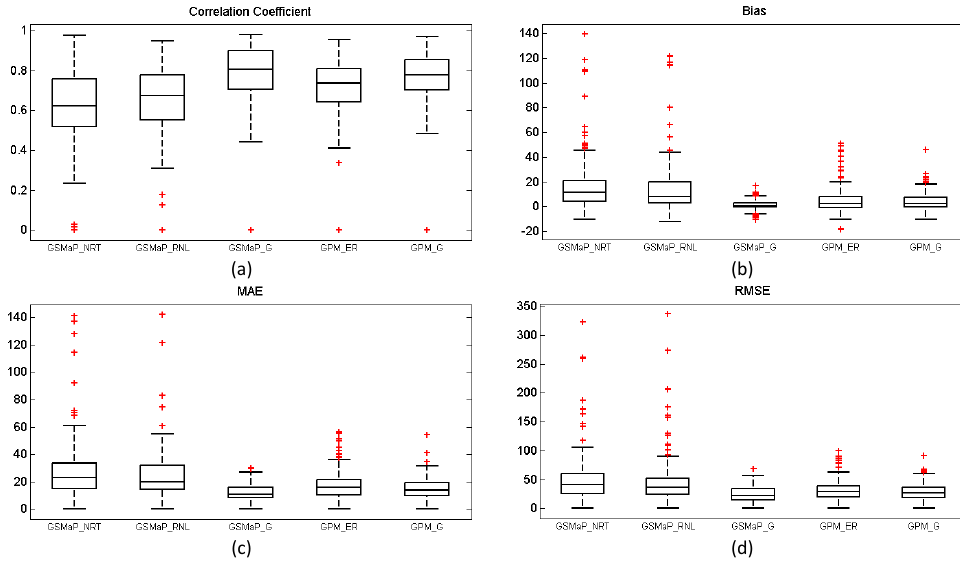
Figure 3. Statistical scores of the satellite rainfall estimation of GSMaP_NRT, GSMaP_RNL, GSMaP_G, GPM_EA, and GPM_G. Red markers denote